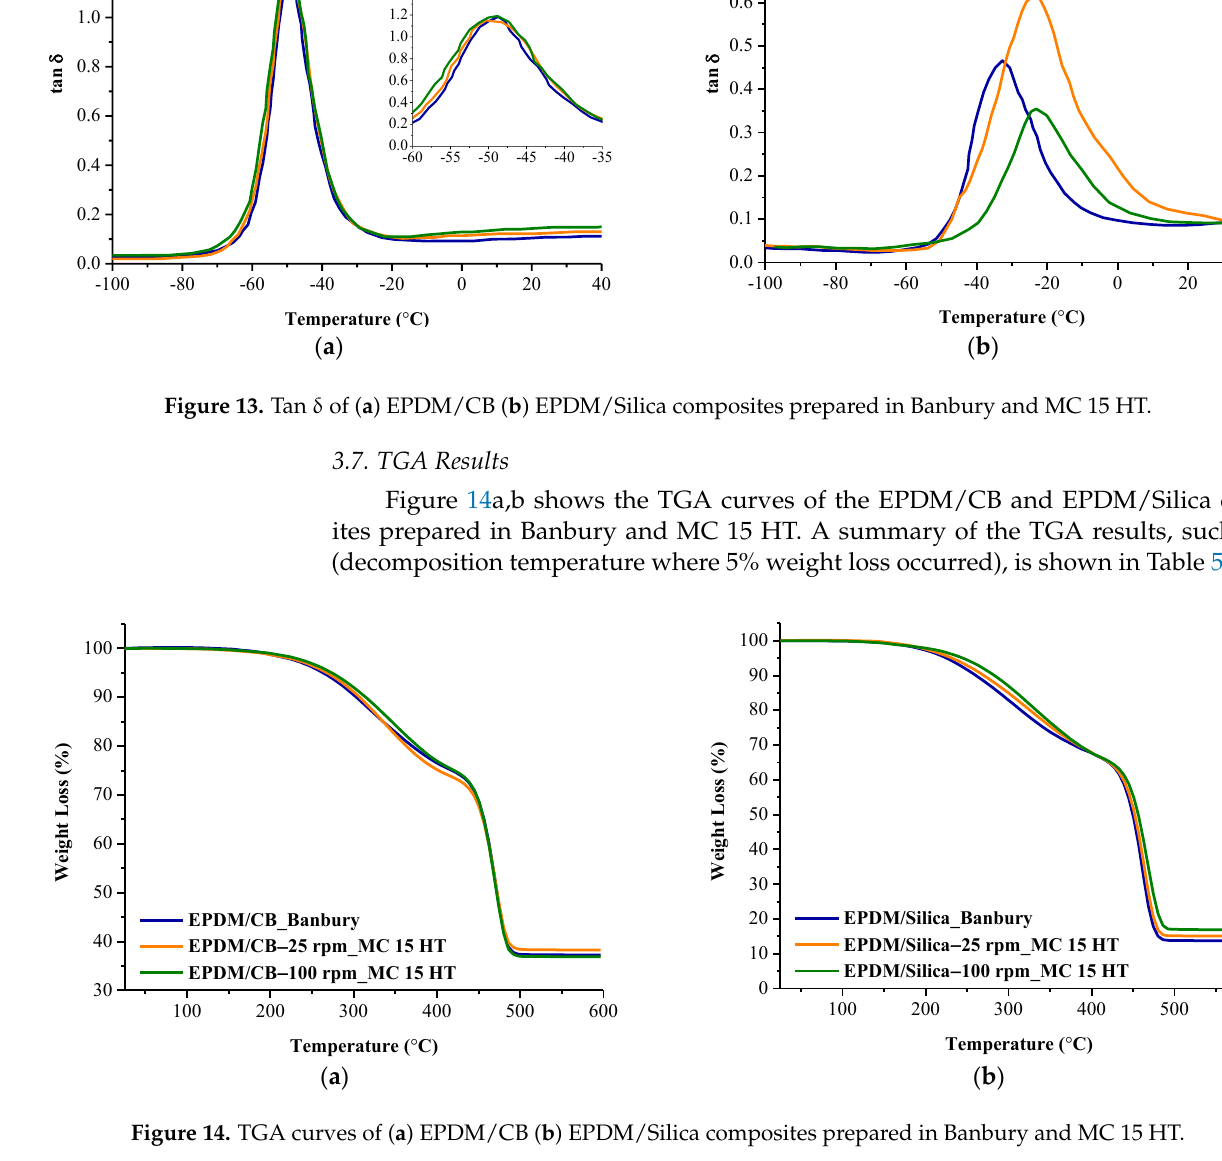
( b ) Figure 12. The storage modulus of ( a ) EPDM/CB ( b ) EPDM/Silica composites prepared in Banbury and MC 15 HT. The temperature corresponding to the peak in DMA analysis can be used as the glass transition temperature of EPDM, as shown in Figure 13a,b. As can be seen from Figure